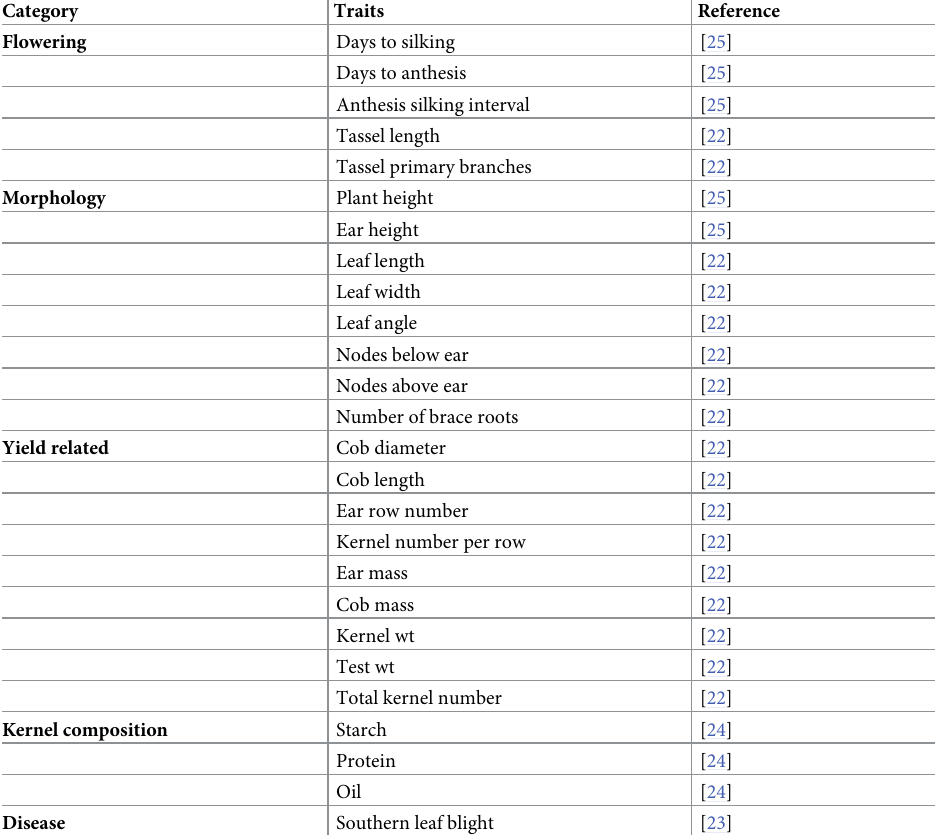
Table 1. Selected traits for genomic